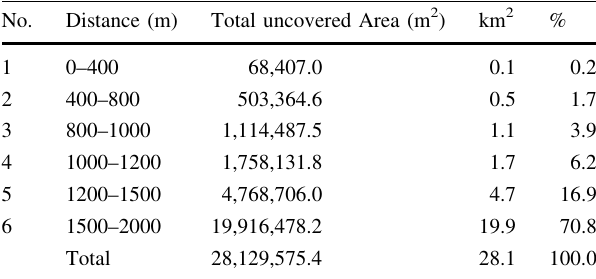
Table 3 Total uncovered service area gaps for six categories distance